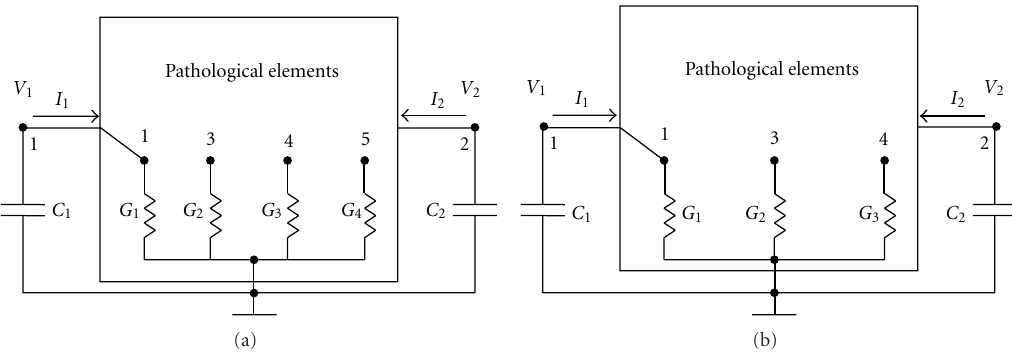
Figure 2: (a) Class-I four grounded resistor five node oscillator. (b) Class-II three grounded resistor four node